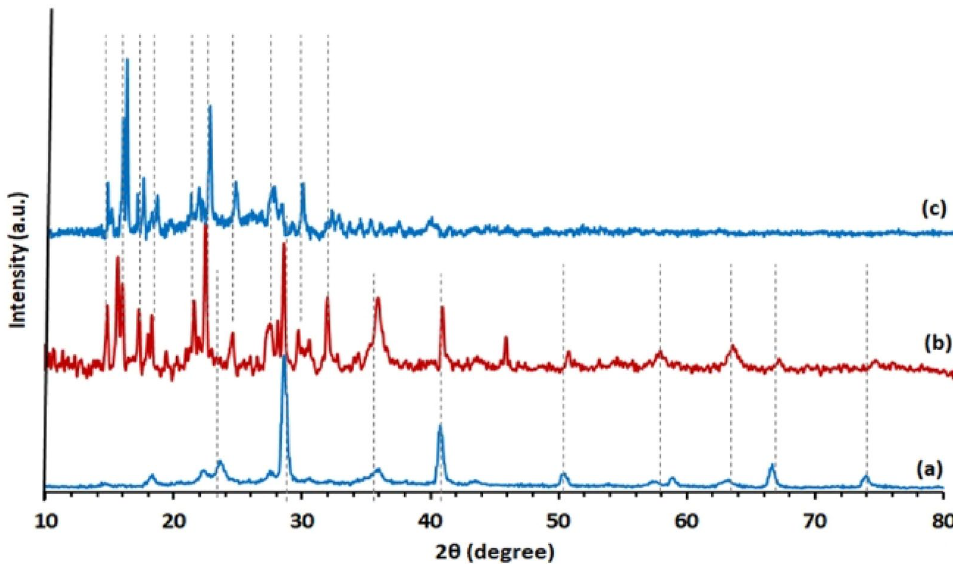
Figure 9. XRD patterns of Fe 3 O 4 @SiO 2 @TAD-G3 ( a ), Fe 3 O 4 @SiO 2 @TAD-G3/Zidovudine ( b ), and Zidovudine ( c ).